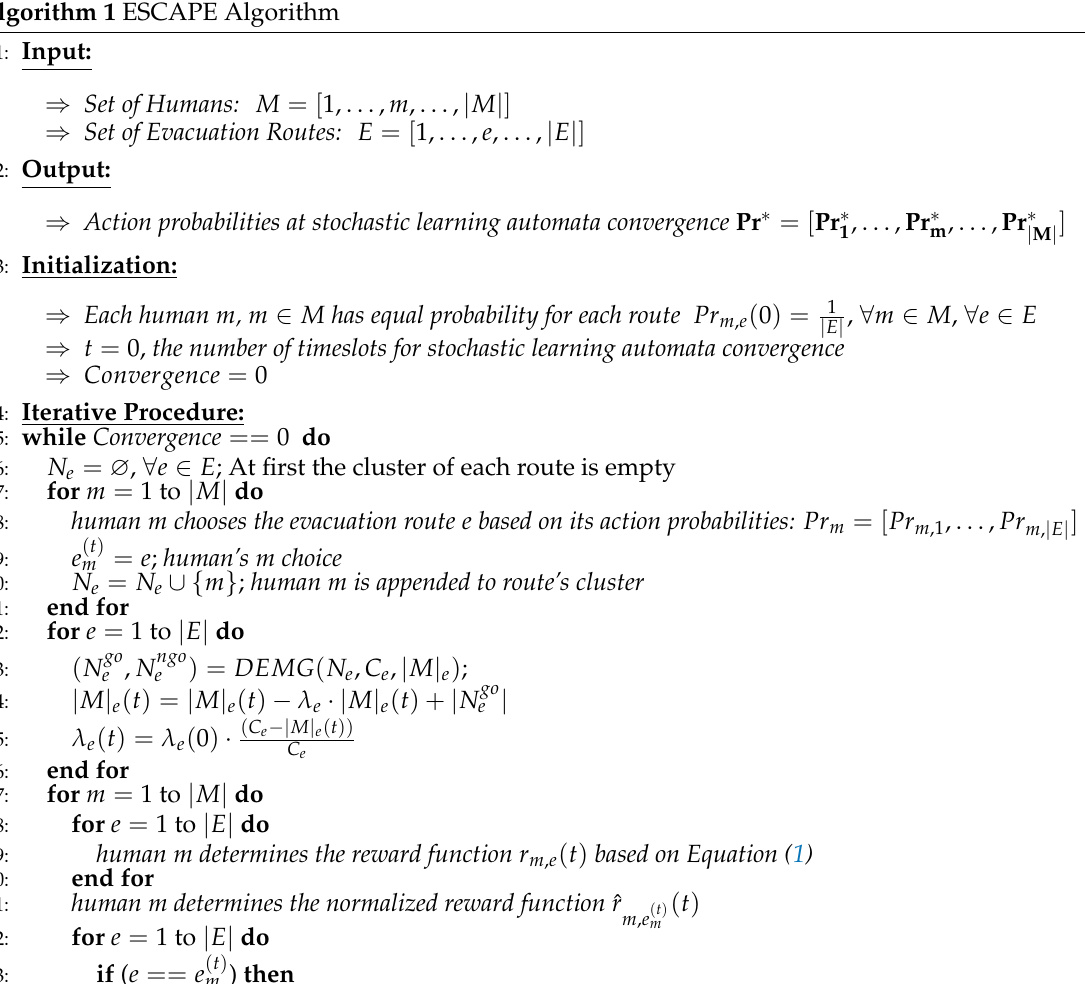
Algorithm 1 ESCAPE